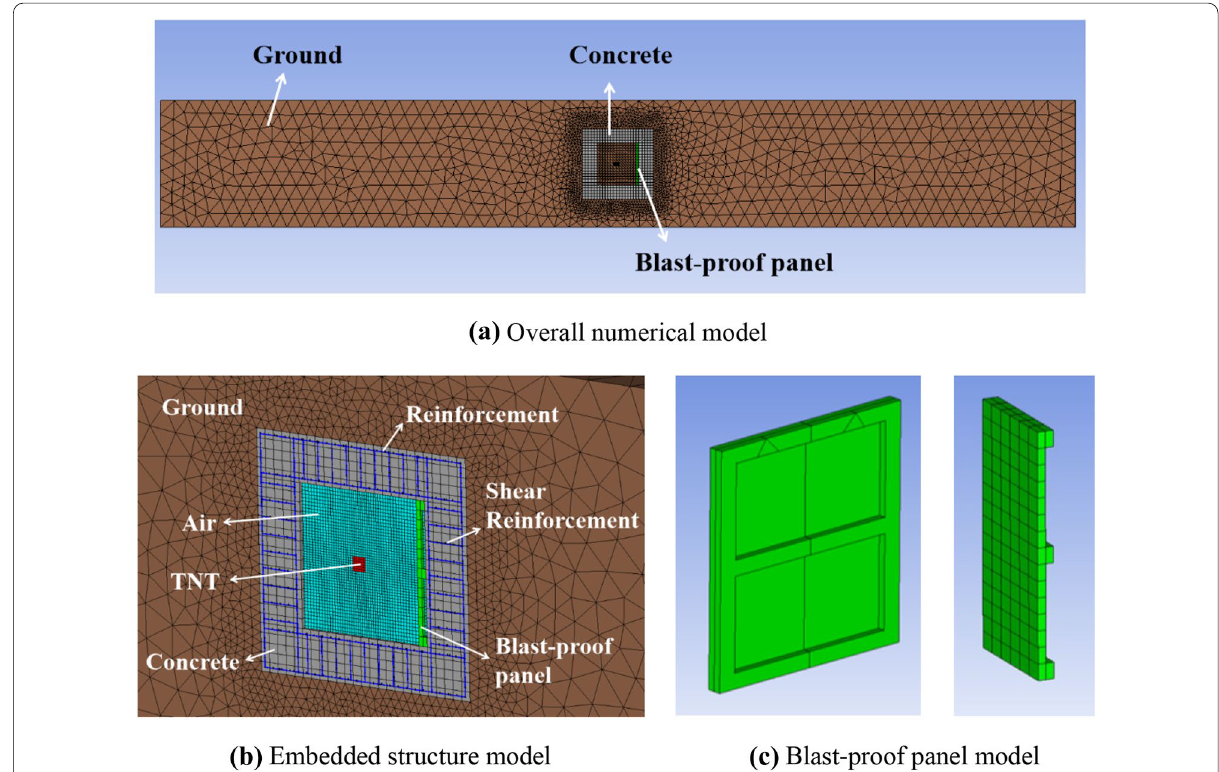
Fig. 7 Modeling result for preliminary numerical simulation.